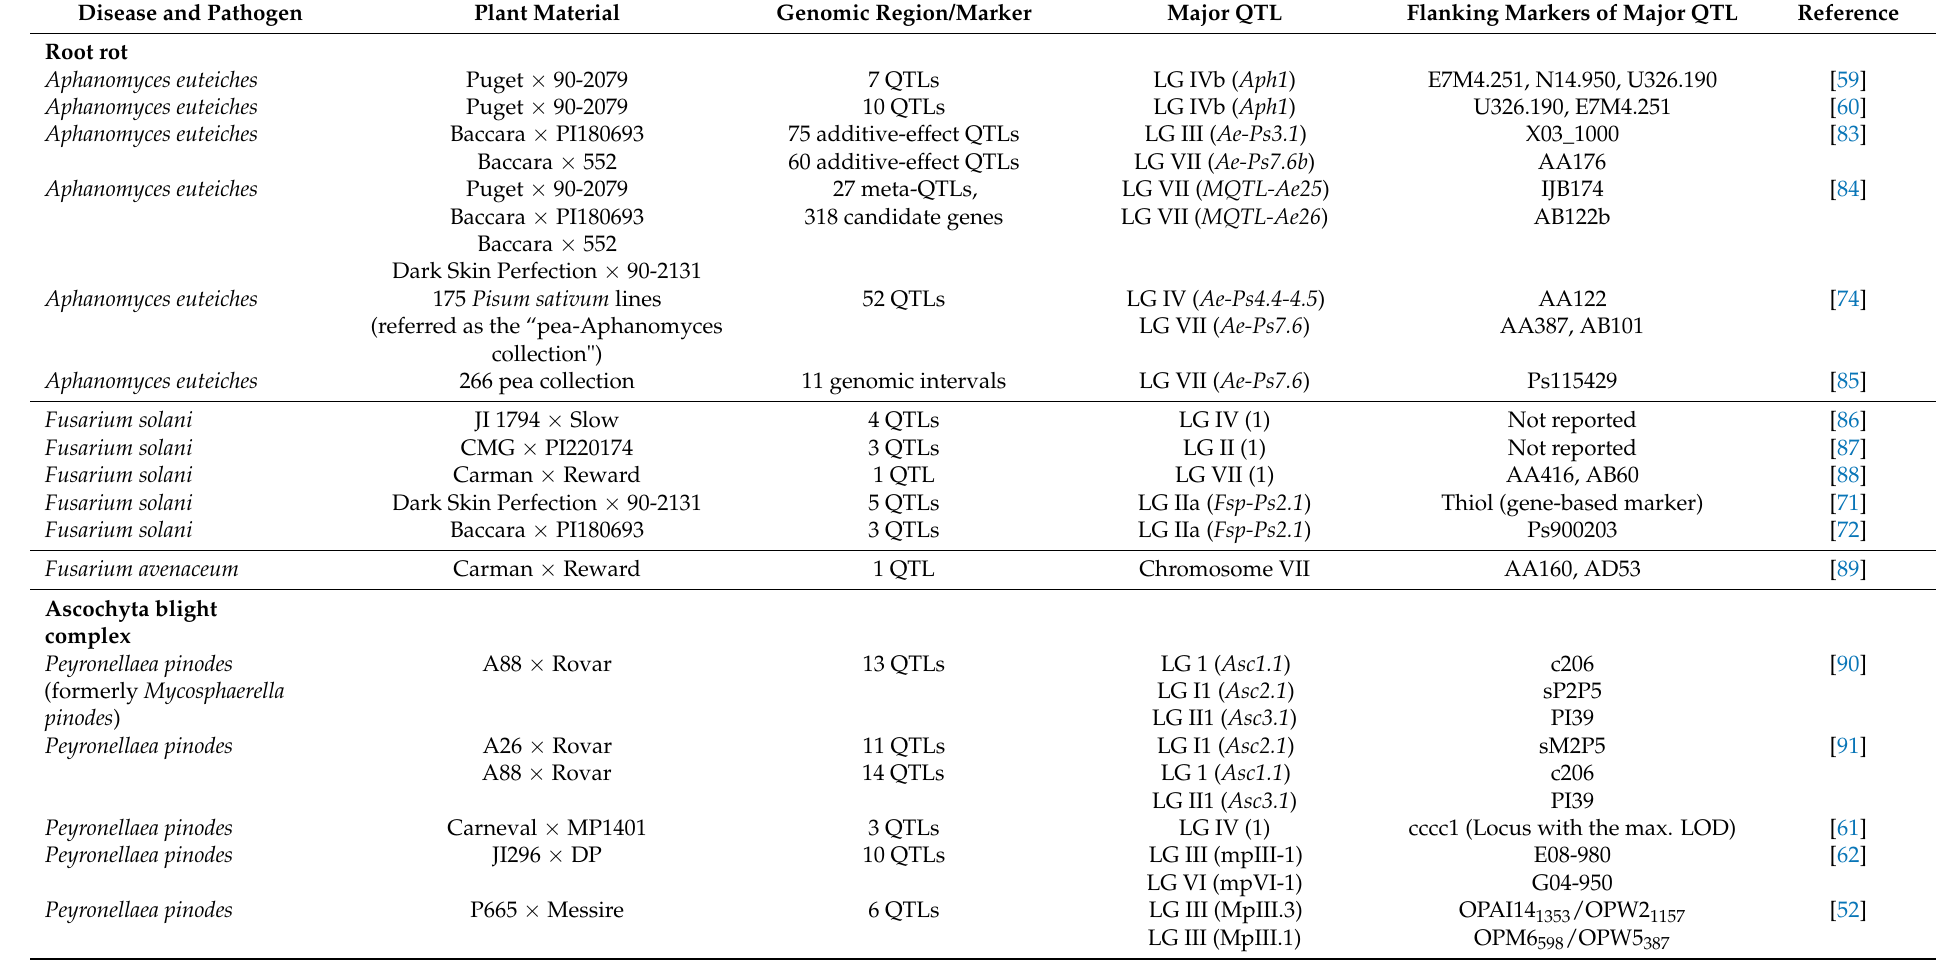
Table 1. Genomic regions and/or markers associated with resistance to root rot, Ascochyta blight complex *, powdery mildew, rust, and white mold in